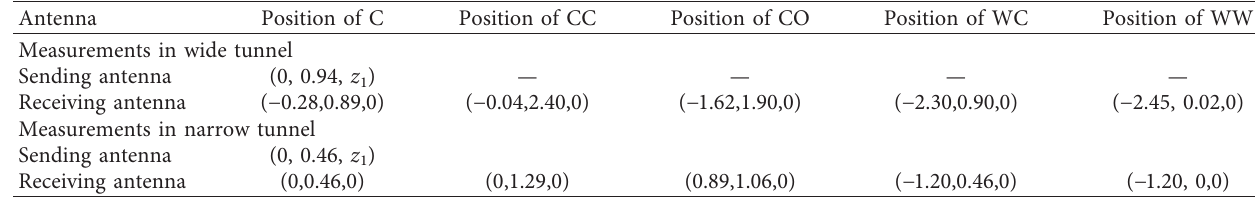
Table 5: Experimental settings: locations of